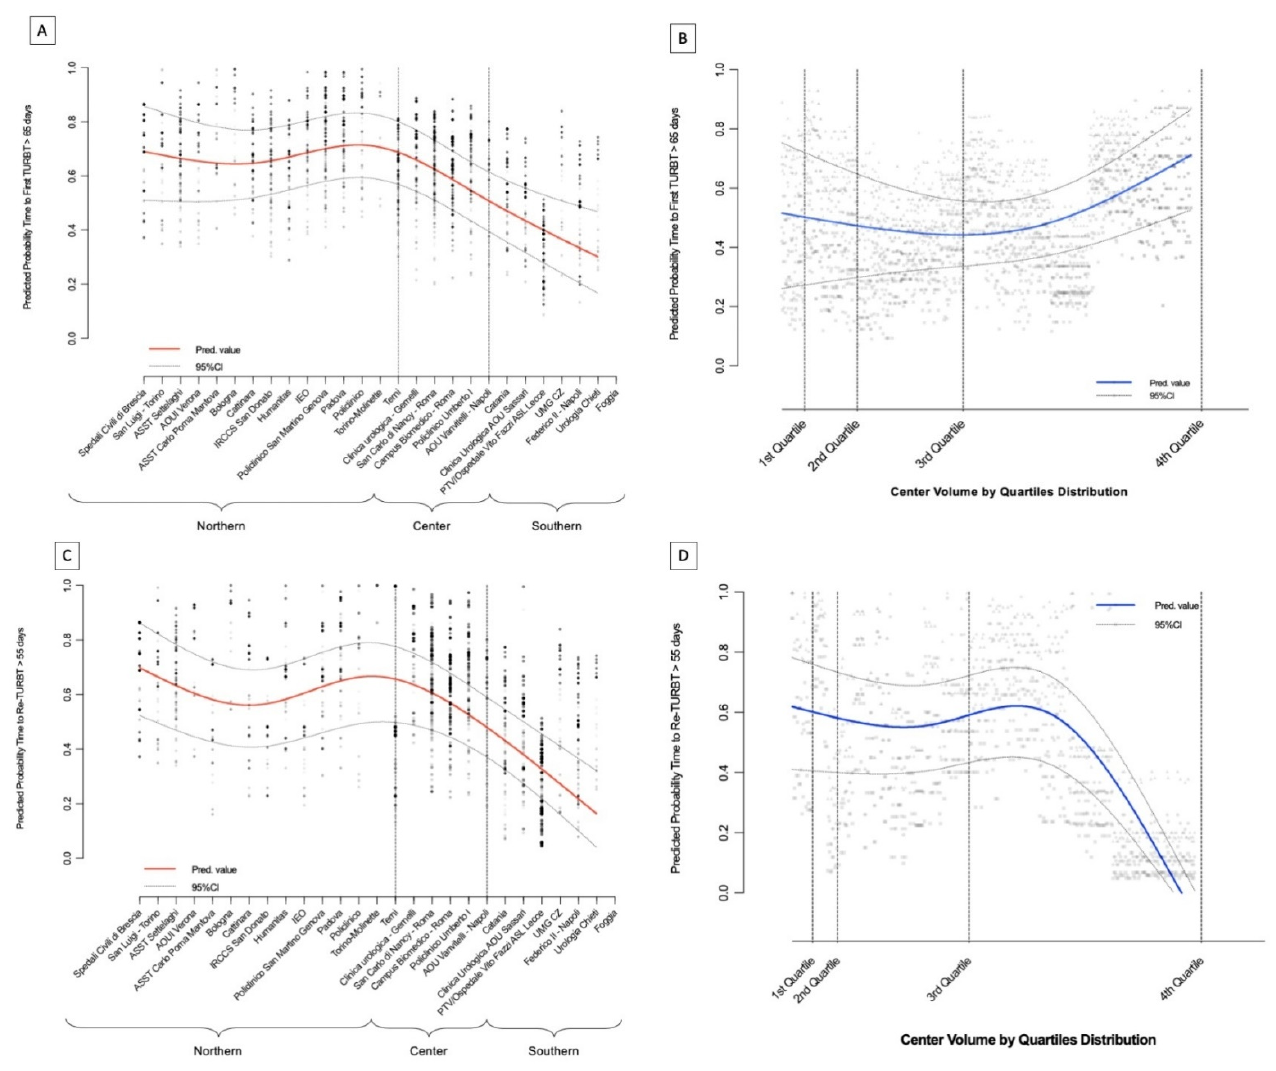
Figure 2. LOWES functions. ( A ) Predicted probability time to first TURB > 65 days among institutions; ( B ) Predicted probability time to first TURB > 65 days among center volume percentiles; ( C ) Predicted probability time to Re-TURB > 55 days among institutions; ( D ) Predicted probability time to Re-TURB > 55 days among center volume percentiles. Table 2. Descriptive characteristics of Re-TURBT cohort. In bold, value < 0.05.